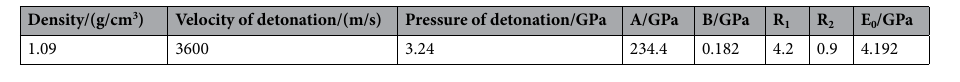
Table 2. Parameters of explosives materials.